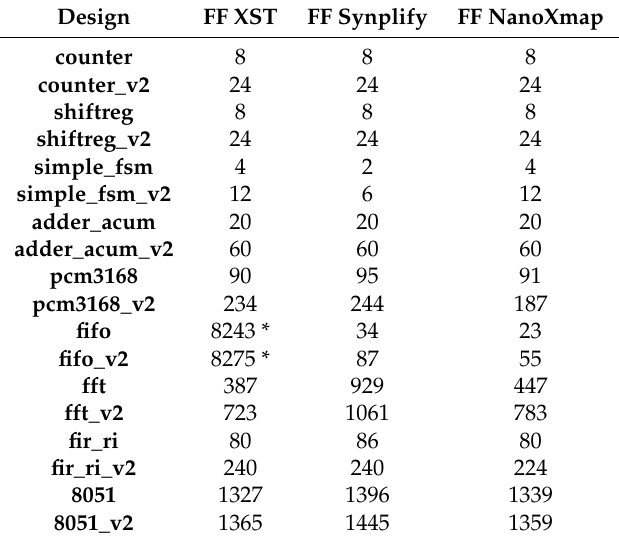
Table 8. Comparison of synthesis results. Data marked with an asterisk (*) corresponds to the synthesizer implementing an internal memory with Flip-flops instead of inferring a Block